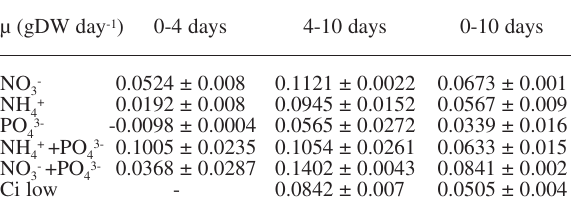
Table 2.- C. linum growth rates (µ ) in each treatment, during the two extractions, between 0 and 4 days, between 4 and 10 days and throughout the experimental period, between 0 and 10 days. Values are means ± standard errors.